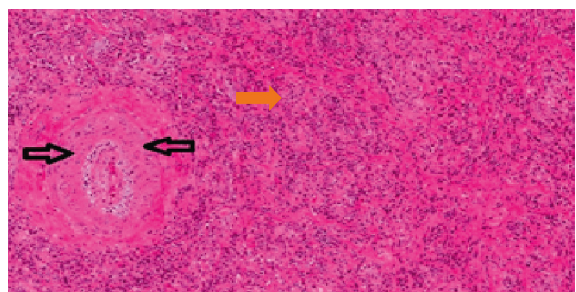
Figure 6: High power field showing arteritis with minimal obliteration of the lumen. The orange arrow shows rich lympho- plasmacytic